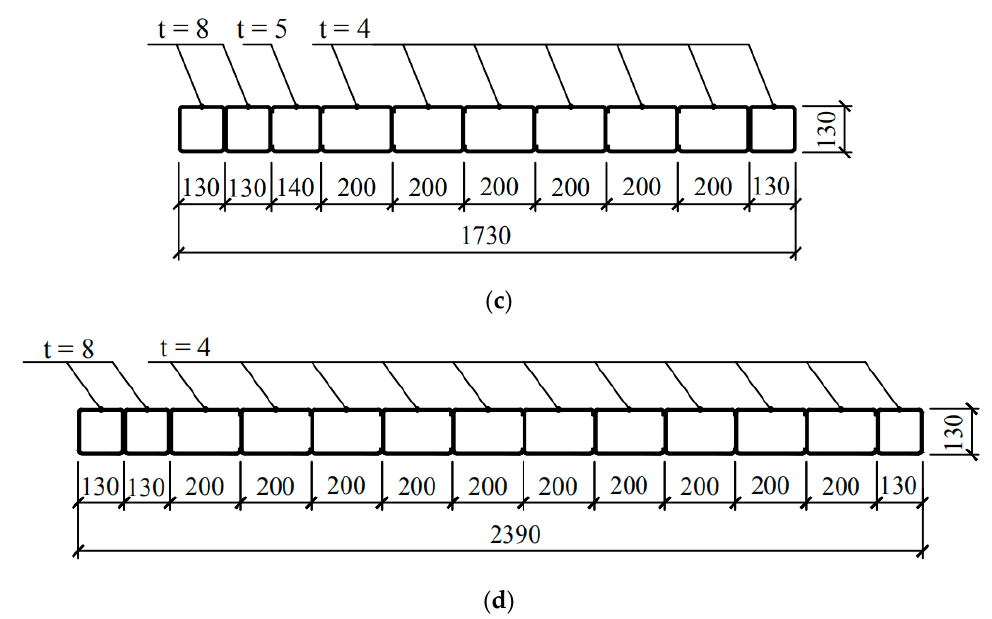
Figure 3. Geometric dimensions of specimens W1 and W2 (units in mm): ( a ) geometric dimensions of specimen W1; ( b ) geometric dimensions of specimen W2; ( c ) cross-section of the BLC-C composite wall of specimen W1; and ( d ) cross-section of the BLC-C composite wall of specimen W2.